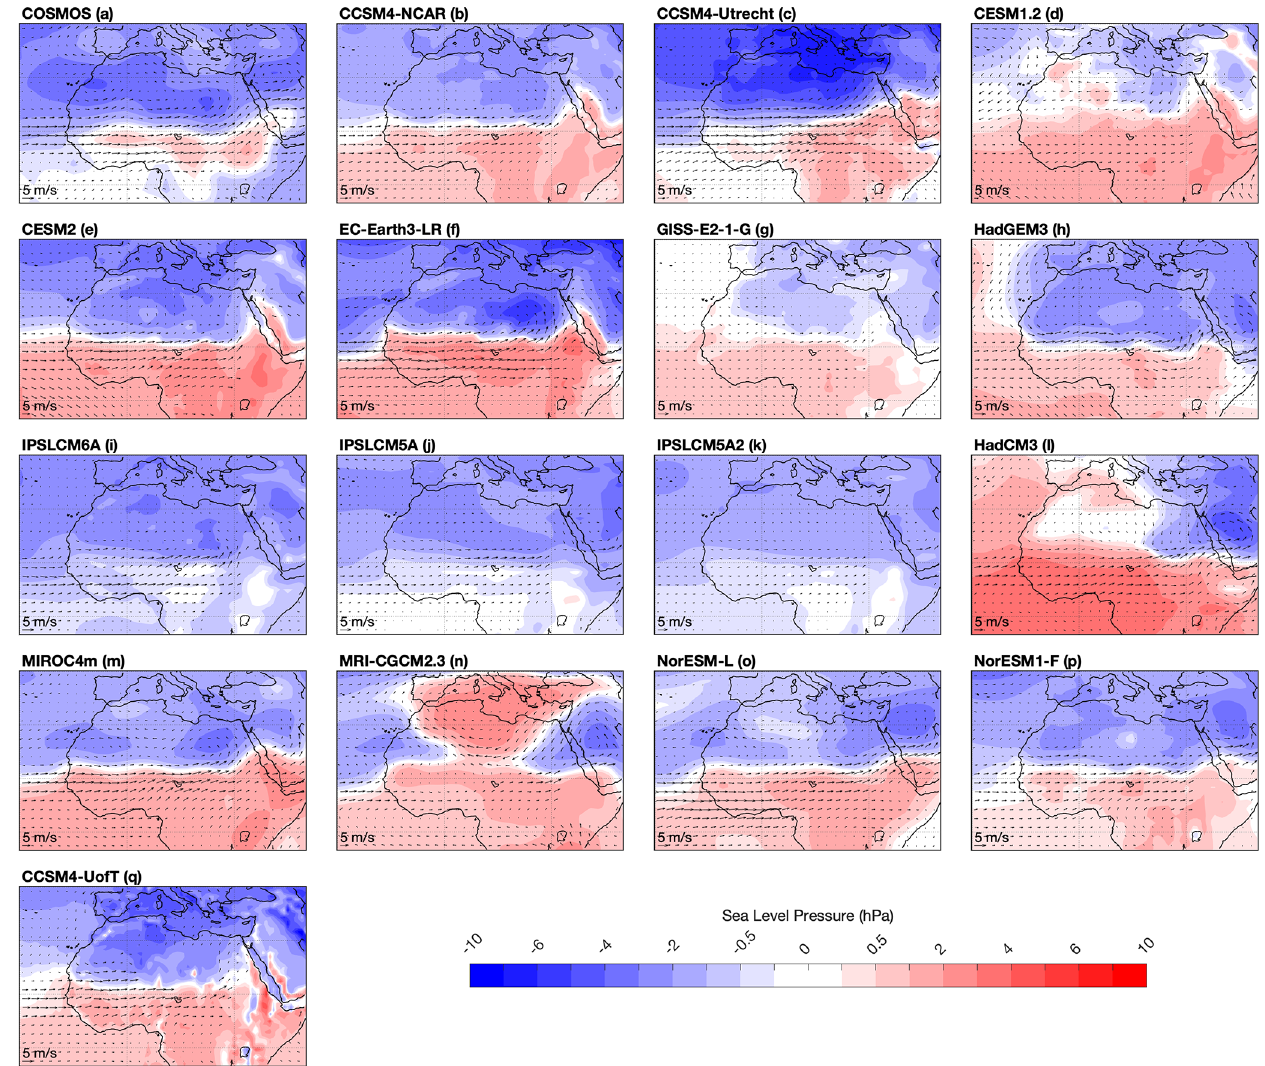
Figure 5. July–October (JASO) mean sea level pressure (shading) and 850hPa horizontal wind (vectors) anomalies for the PlioMIP2 en- semble members (a–q)